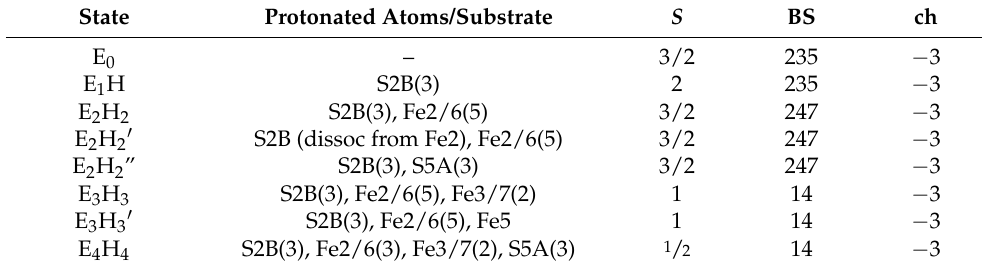
Table 5. Structures studied for the E 0 –E 8 states of the FeMo cluster. The table lists the protonated atoms or the added substrate, the spin state ( S ), the BS state (specifying the Fe ions with minority spin), and the net charge of the QM systems (ch; same for both for QM/MM and for the redox calculations). State Protonated